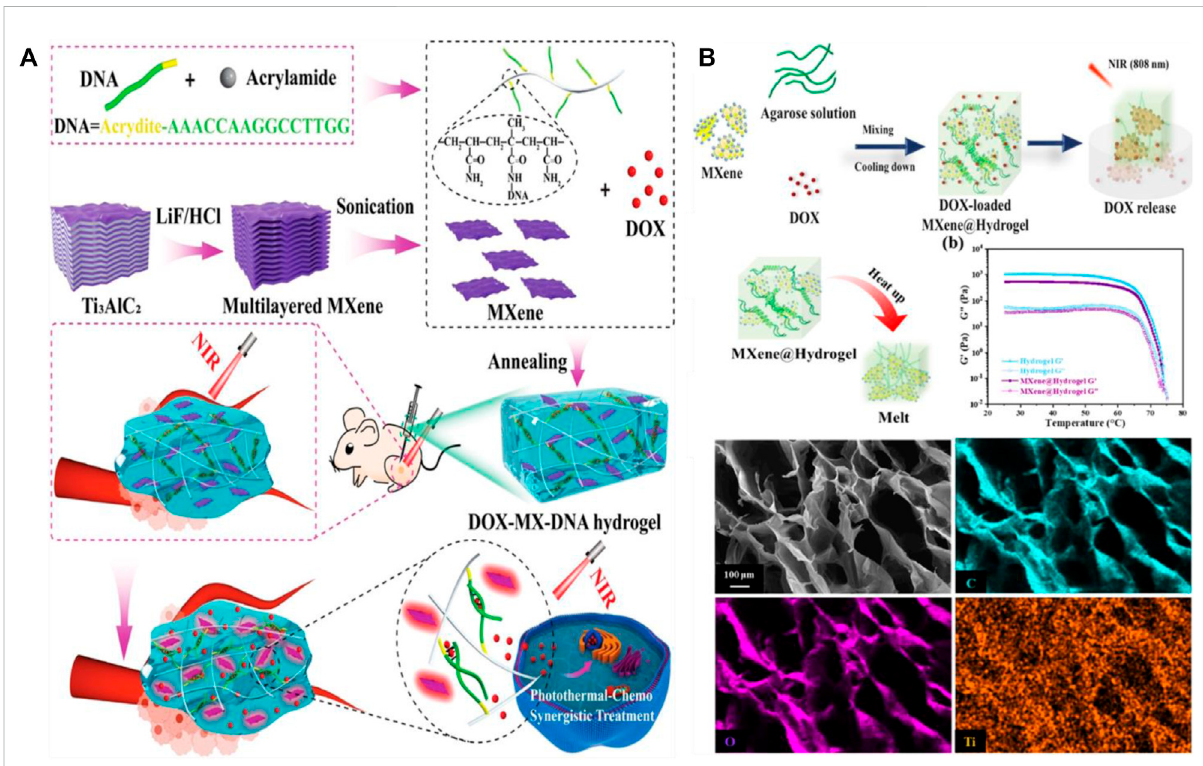
FIGURE 5 (A) Schematic diagram of the principle of MXene-DNA hydrogel loaded drugs in cancer treatment. Reproduced from ref. 29 with permission from 2022 Wiley-VCH GmbH. (B) Schematic diagram of synthesis and melting after heating of MXene based photothermal hydrogel. Reproduced from ref. 16 with permission from 2021 Published by Elsevier